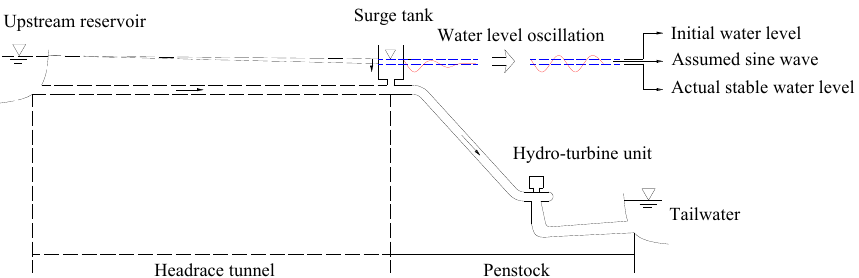
Figure 15. Pipeline system of the hydropower station with a surge tank and the sine wave of the water level in the surge tank [70].